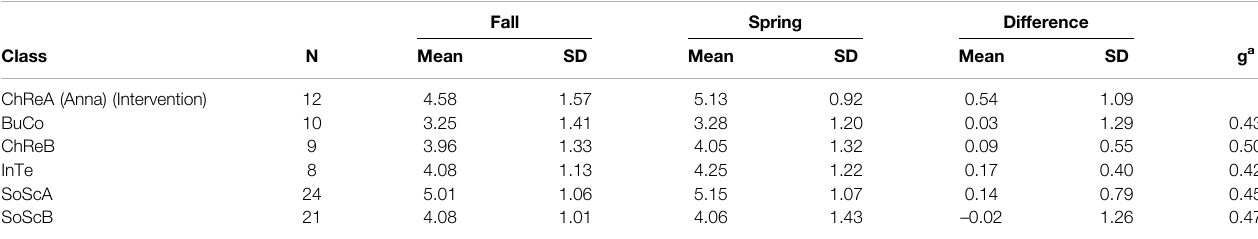
TABLE 3 | Autonomous motivation in the intervention and comparison classes in the fall and spring and their difference. Fall Spring Difference Class N Mean SD Mean SD Mean SD g a